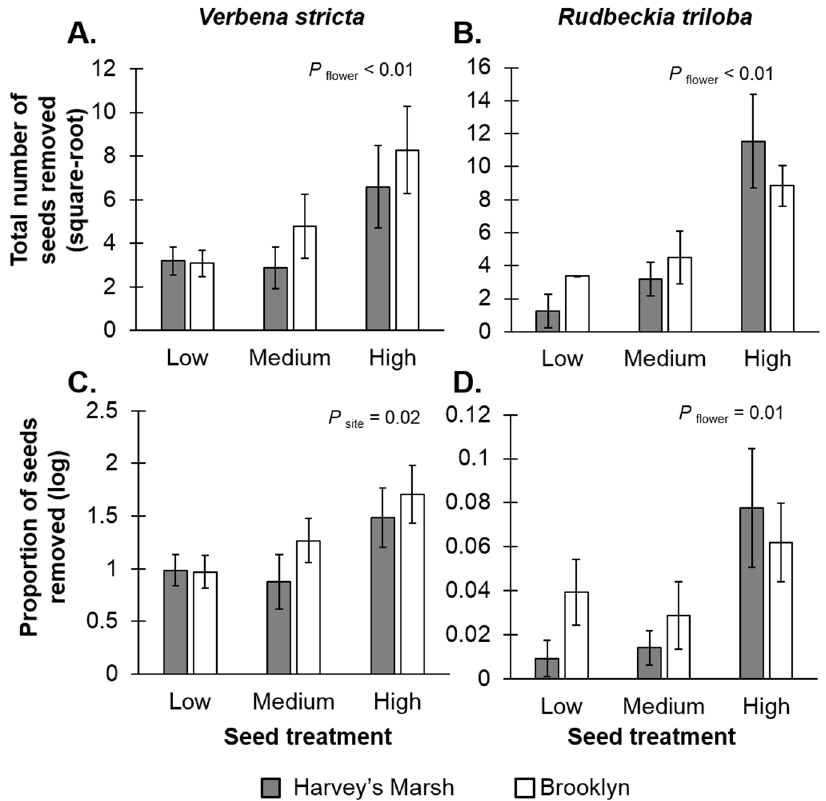
Figure 2. Seed treatment and site comparisons of Verbena stricta (left side) and Rudbeckia triloba (right side) on the total number of seeds removed ( A , B ) and the proportion of seeds removed after 48 h of exposure ( C , D ). Grey bars represent rates at Harvey’s Marsh (a low resource density site); white bars represent rates at Brooklyn (a high resource density site). Error bars represent ±1 SE. The total number of seeds removed was square-root transformed, and the proportion of seeds removed was log- transformed.